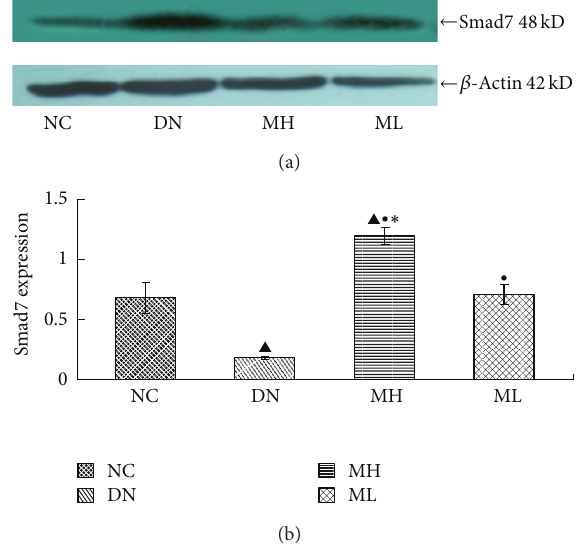
Figure 3: Smad7 protein expression in each group by Western blot. (a) Western blot strip chart. (b) The gray graph shows the relative statistical values of Smad7 for each group. Compared with the NC group, Smad7 expression decreased in the experimental groups, especially in the diabetic nephropathy group, with a subsequent increaseintheMHandMLgroups,andamorepronouncedincrease intheMHgroupcomparedwiththeMLgroup. 󳵳 𝑃 < 0.01 versusNC group, e 𝑃 < 0.01 versus diabetic nephropathy group, and ∗ 𝑃 < 0.05 versus ML group.